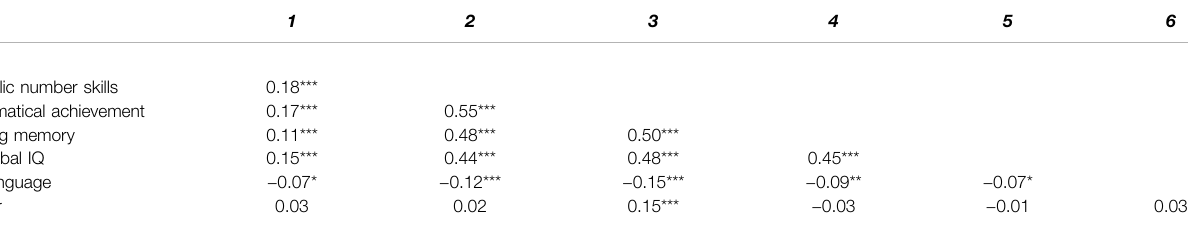
Frontiers in Education |